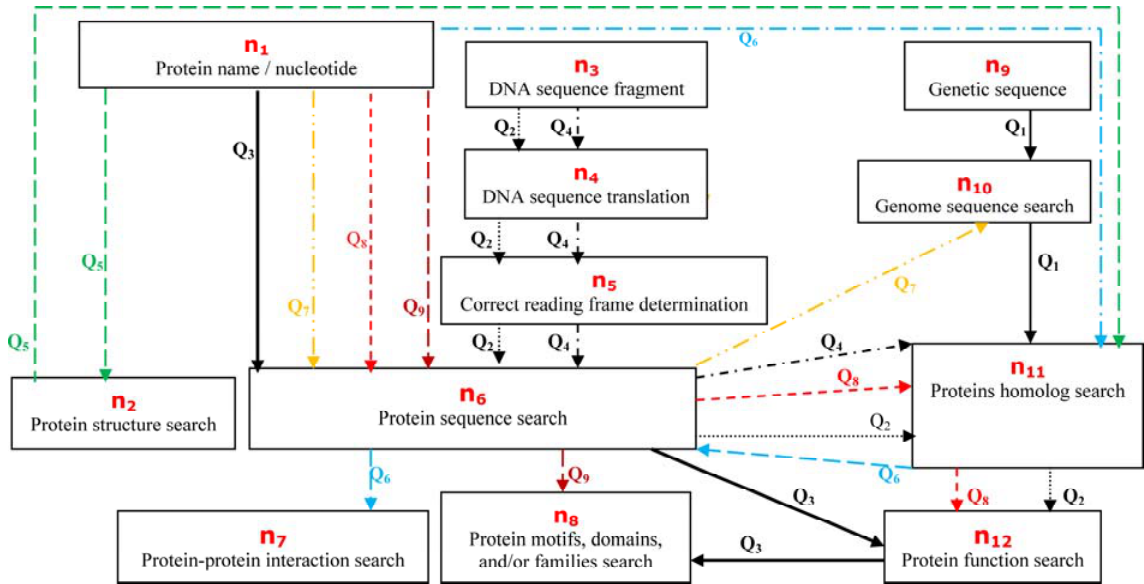
Fig. 2: A GQG showing the paths of the 9 Query Types in Fig. 1 ( n